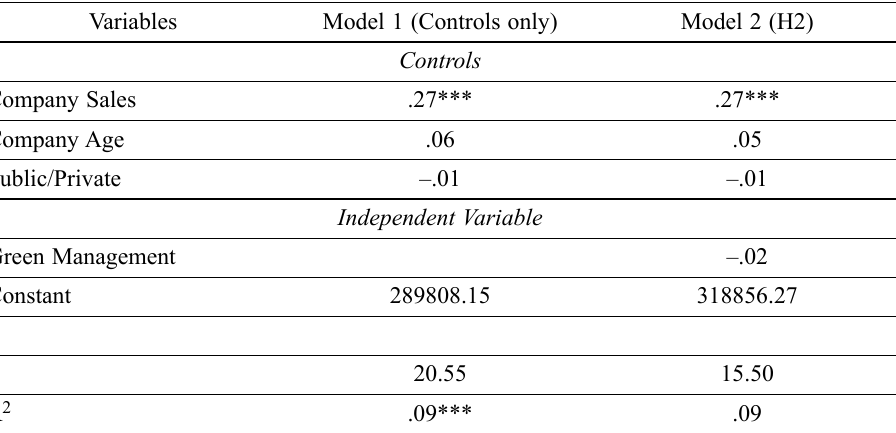
Table 5. Results of the regression analysis for CEO bonus ( N =